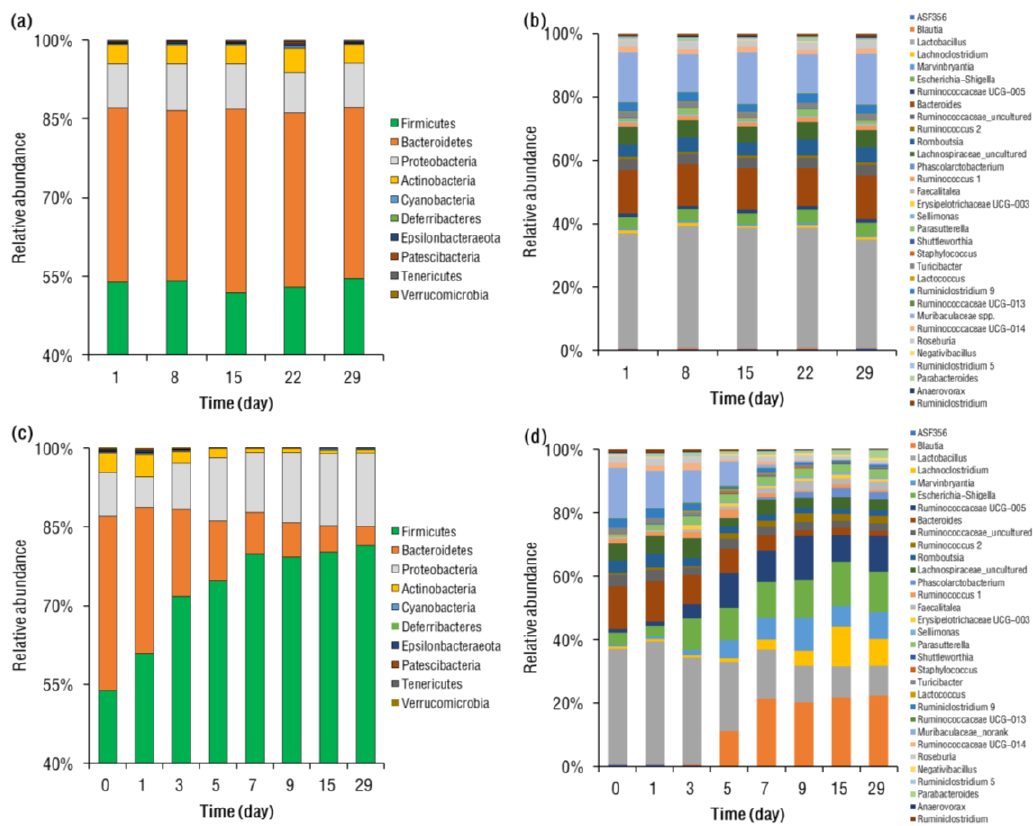
Figure 2. Change in the relative abundances of gut microbiota at ( a ) phylum and ( b ) genus levels in SD rats over time, following intermittent oral administration of BPA. Change in the relative abundances of gut microbiota at ( c ) phylum and ( d ) genus levels in SD rats over time, following continuous oral administration of BPA.